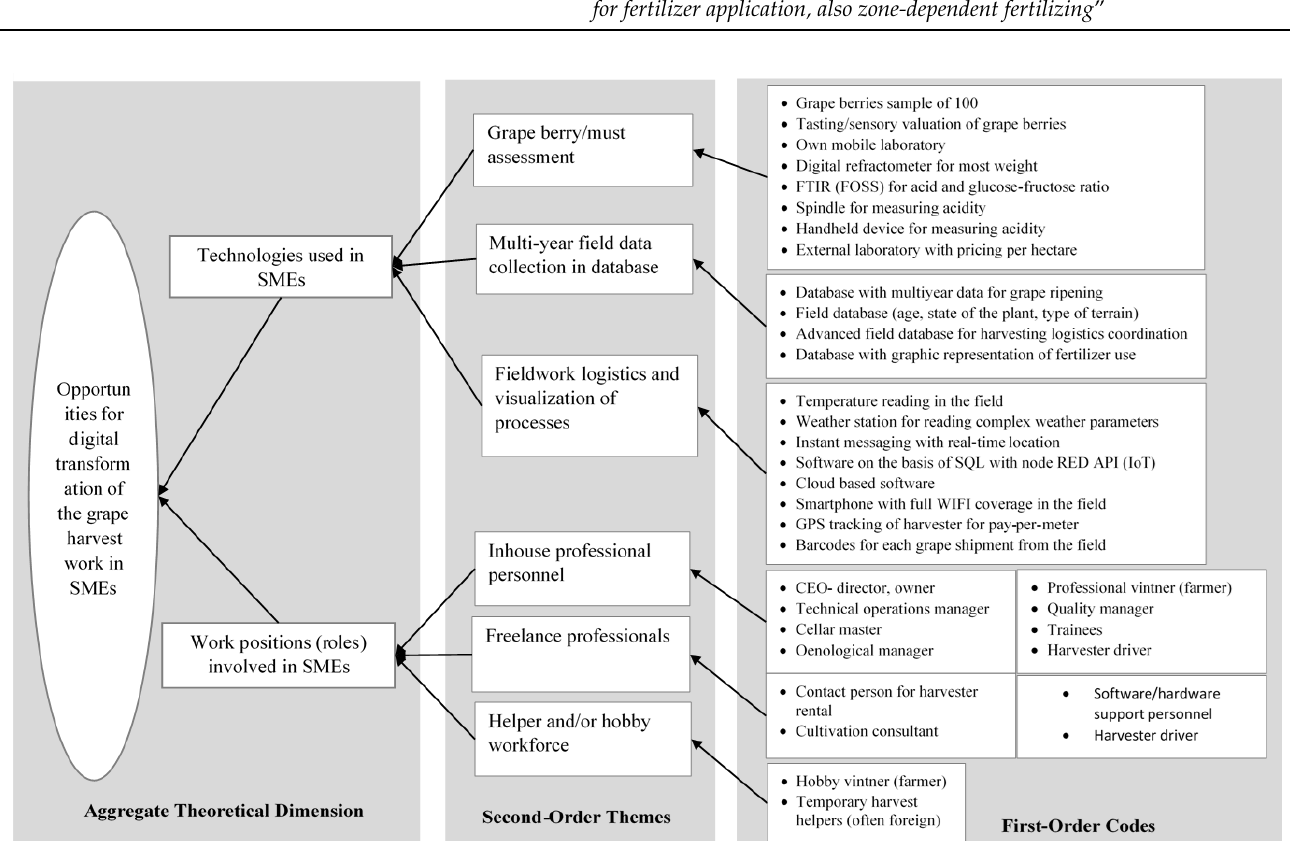
Figure 1. Current state of the grape harvest process regarding technologies used and actors involved.